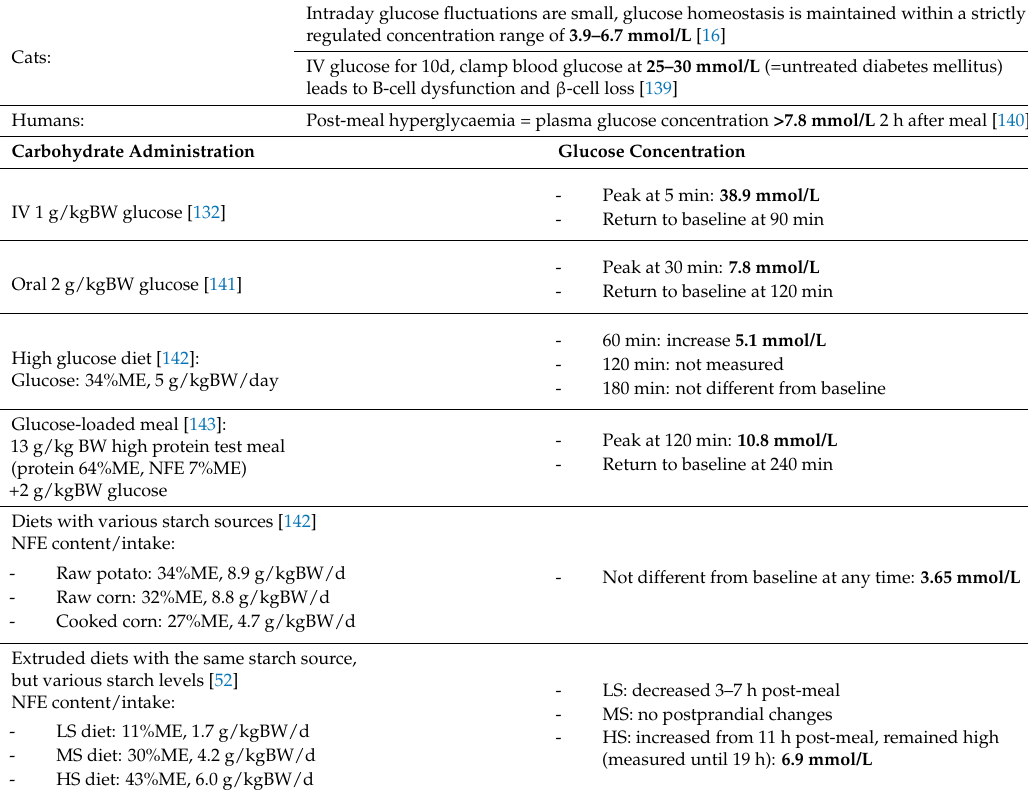
Table 3. Blood glucose response in healthy normal-weight cats following administration of IV glucose, oral glucose, and diets with various carbohydrate levels. Blood glucose concentrations are compared to normal glucose homeostasis in cats [16], concentrations causing β -cell dysfunction and β -cell loss in cats [139] and the definition of post-meal hyperglycaemia in humans according to the International Diabetes Federation